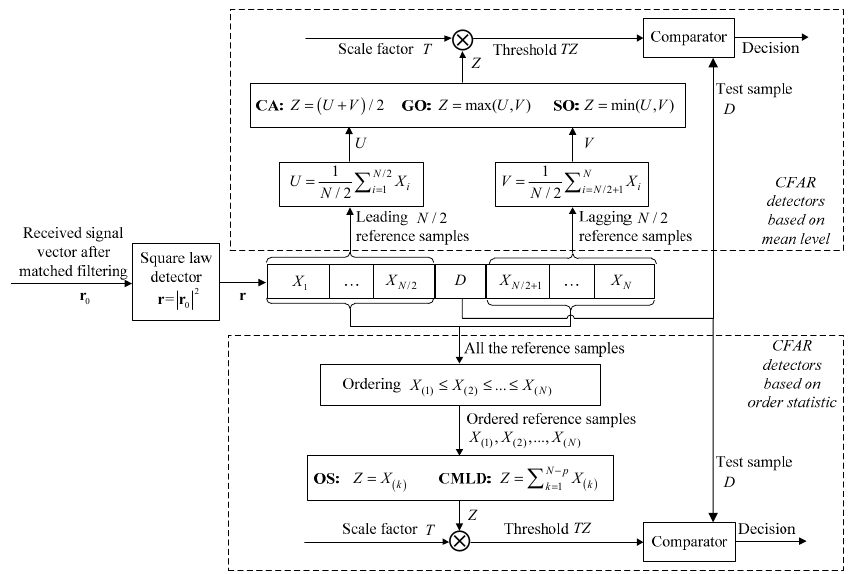
Figure 1. The procedures of cell averaging (CA), Greatest Of (GO), Smallest Of (SO), Order Statistic (OS) and censored mean level (CML) detectors.